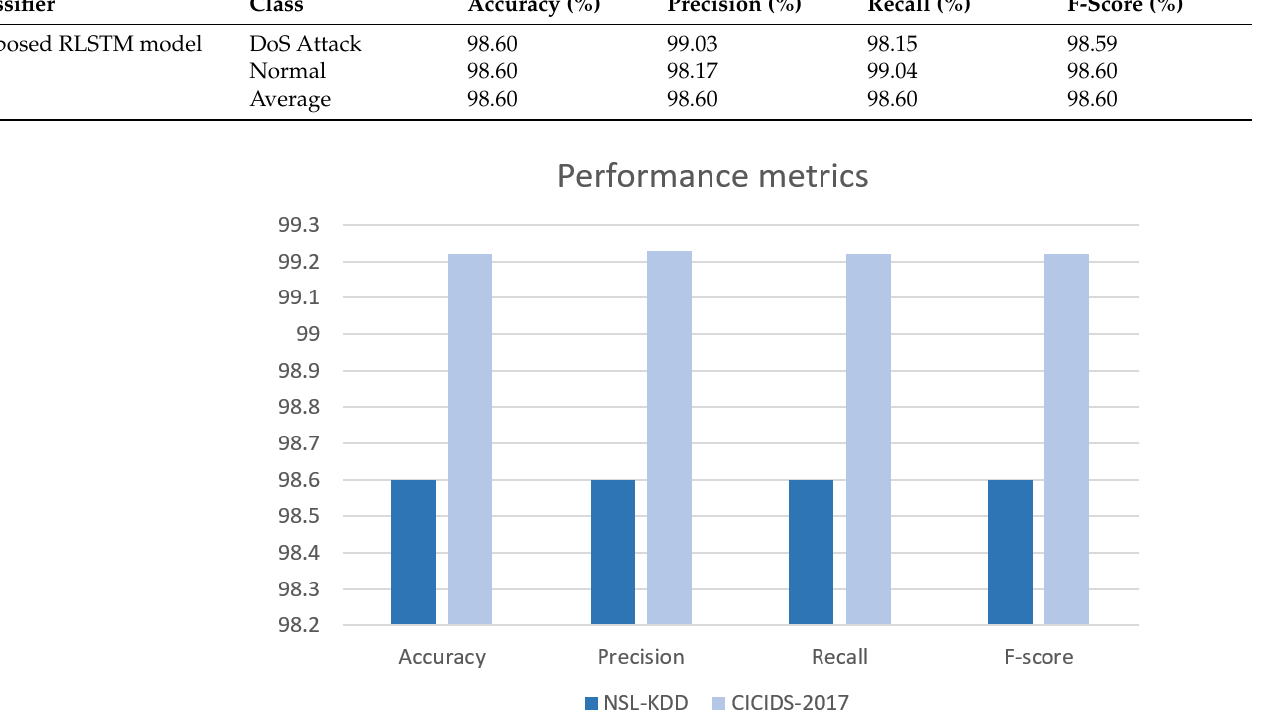
Table 6. Results of MLPNN (NSL-KDD).